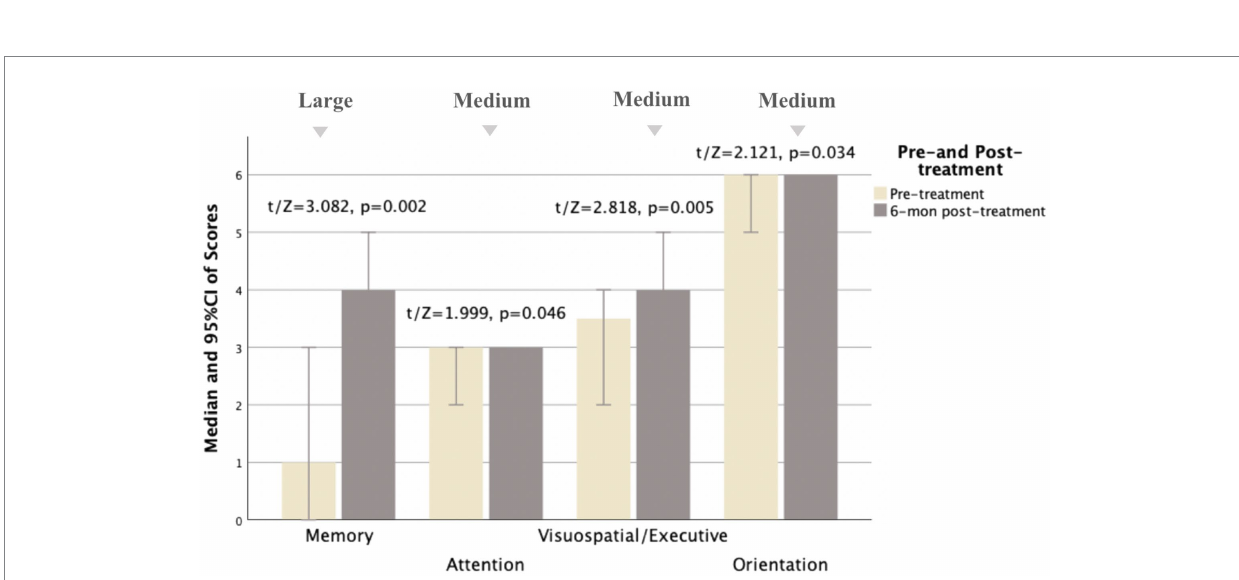
FIGURE 3 Comparison of MoCA subscale scores pre- and 6 months post-treatment for MD patients ( N = 21). Compared to pre-treatment, MoCA subscale scores improved mainly in memory, attention, visuospatial/executive, and orientation aspects ( t /Z = 3.082, 1.999, 2.818, and 2.121, and p < 0.05) at 6 months post-treatment, especially in memory and visuospatial/executive aspects ( p < 0.01). Small, medium, and large indicate clinically meaningful Cohen d effect